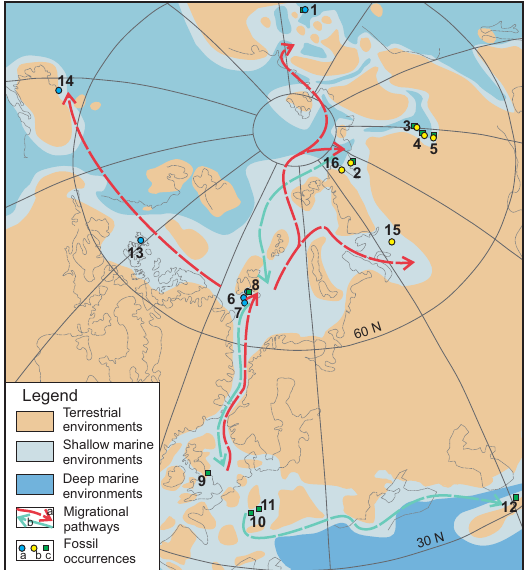
Figure 5. Simplified palaeogeography of the early Toarcian (modified from van der Schootbrugge et al., 2020, with minor corrections) and possible immigrational routes for Meleagrinella (Clathrolima) (blue; occurrences of M. (C.) substriata marked by green squares) and Dactylioceras (red; occurrences of D. (D.) kopiki – D. (Microdactylites) sp. marked by blue circles, while findings of other Dactylioceras ex gr. commune – by yellow circles). Key localities and their clusters are indicated by numerals: 1 – Astronomicheskaya river, NE Russia (this paper); 2 – Anabar Bay, Northern Siberia (Lutikov & Arp, 2020b); 3 – Tyung river, Yakutia (Lutikov & Arp, 2020b); 4 – Markha river,